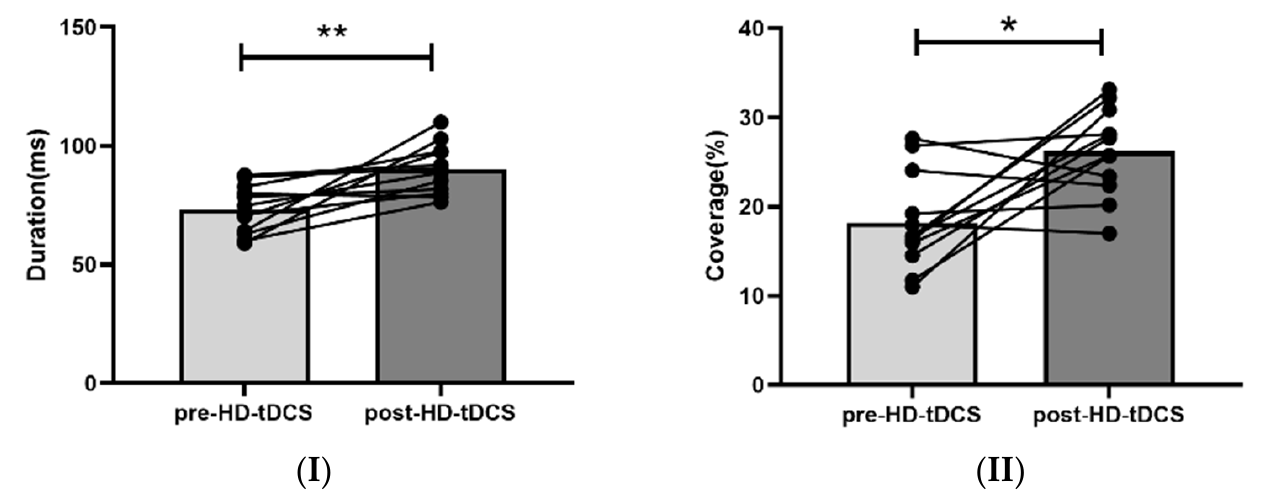
Figure 4. The changes of duration ( I ) and coverage ( II ) of microstate class C parameters before and after HD-tDCS in the responsive group. * p < 0.05; ** p < 0.01.